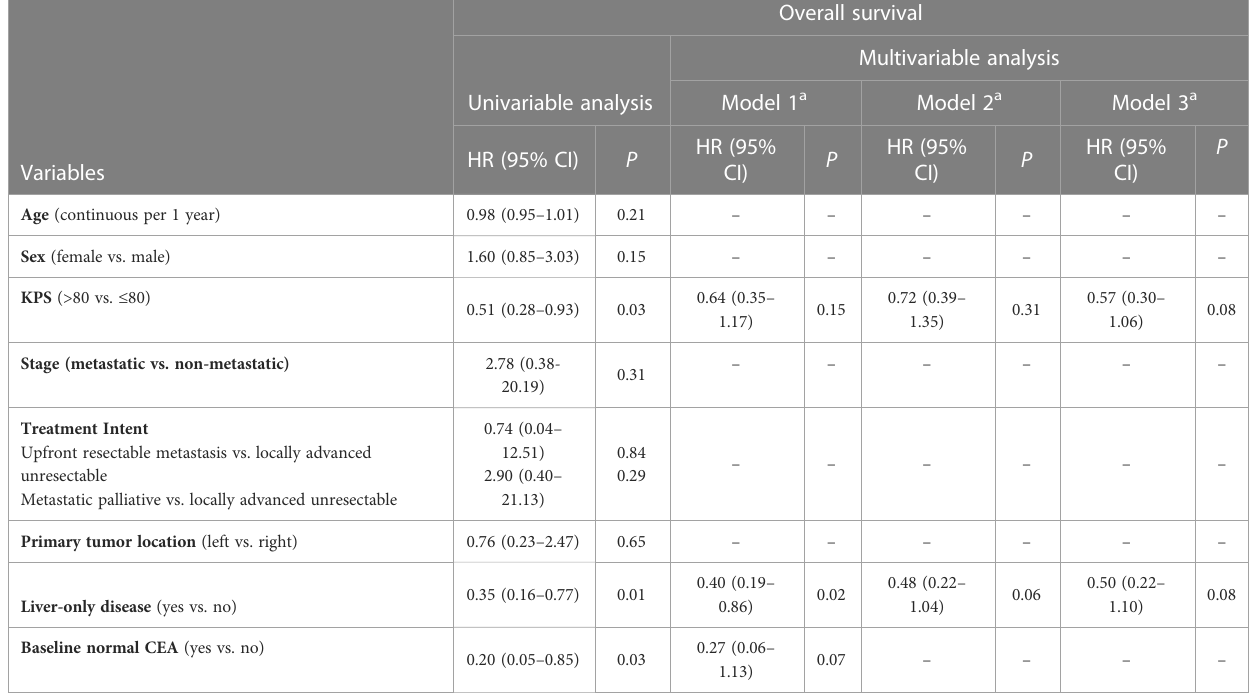
TABLE 4 Univariable and multivariable analyses of prognostic factors for overall survival, Hong Kong, 2019 – 2021 (N = 106).